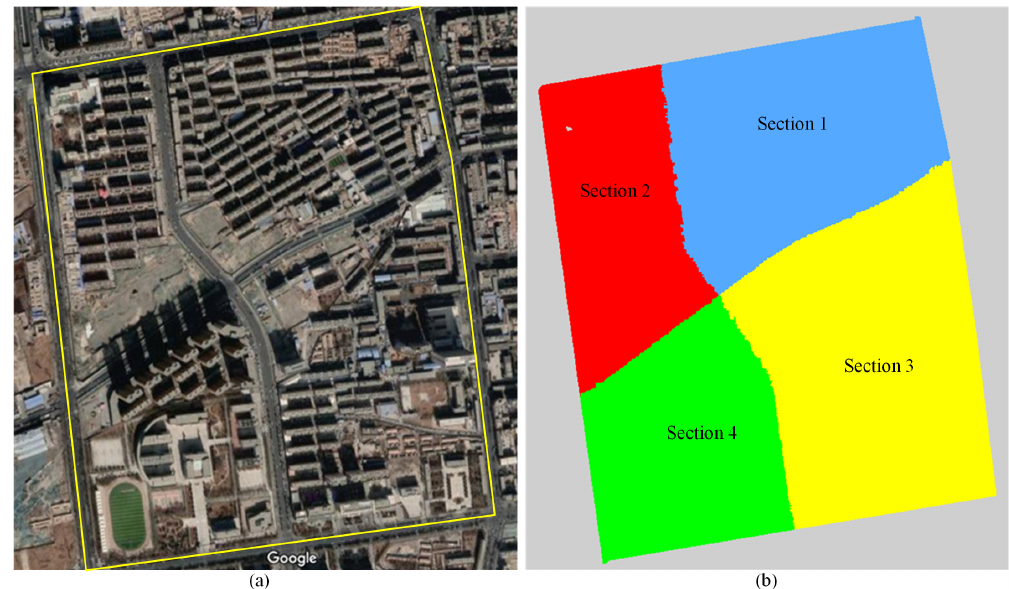
Figure 3. Covered area and separated sections. ( a ) Description of the covered area (Satellite imagery from Google Maps). ( b ) Illustration of four separated